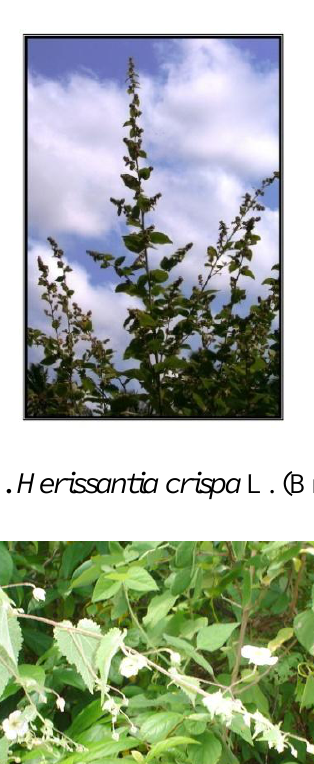
Figure 2. Wissadula periplocifolia (L.) C. Presl.